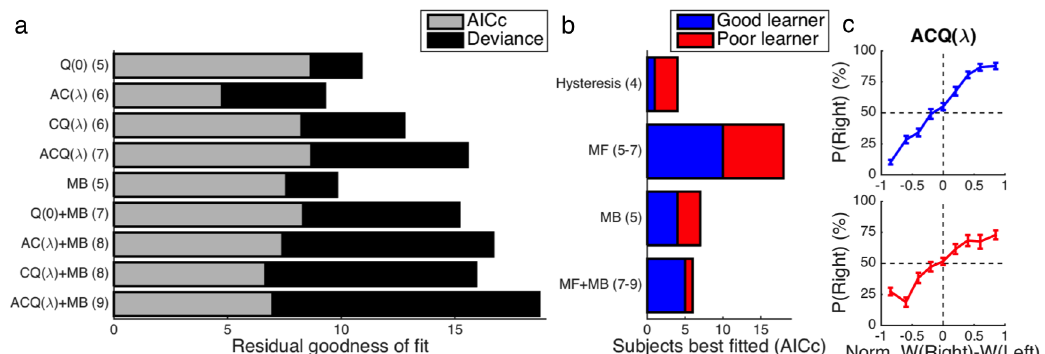
Fig 2. Model fitting and behavior. (a) Average goodness of fit relativeto the outcome-insensitivehysteresis model across performingsubjectsis shown for each model tested with (light bars) and without (light and dark bars combined)a penalty for model complexityaccordingto the AICc. A positive residualcorrespondsto a superiorfit. After correcting for model complexity, the 7-parameter ACQ model providedthe best overall fit for the data. Degreesof freedom are listed in parentheses. (b) At the level of individual subjects, the AICc generallyfavored a model-free (MF) algorithmas opposed to a model-based (MB) algorithmor some combination of the two within both the Good-learner group (blue bars) and the Poor-learnergroup (red bars). (c) The relationshipbetweenthe normalized difference in the net action weights W t (s t , a) predictedby the ACQ model and observedchoices is plotted separately for the Good-learner (blue line) and Poor- learner(red line) groups. Error bars indicatestandard errors of the